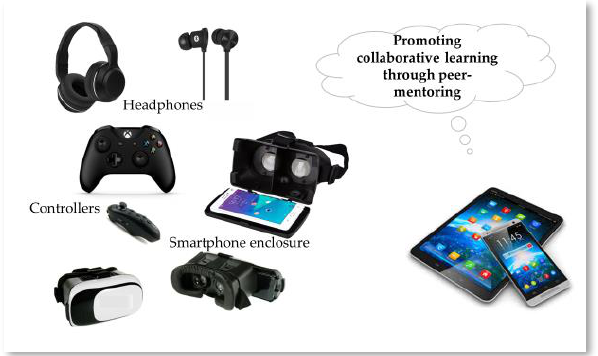
Figure 6. WUIM transmedia educational project ( source : adapted from Pratten [80] (p. 2)).